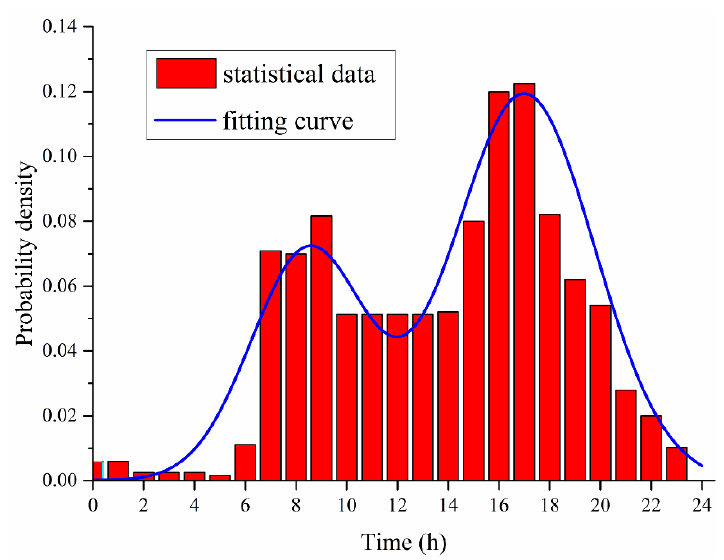
Figure 7. The distribution of vehicle arrival time at